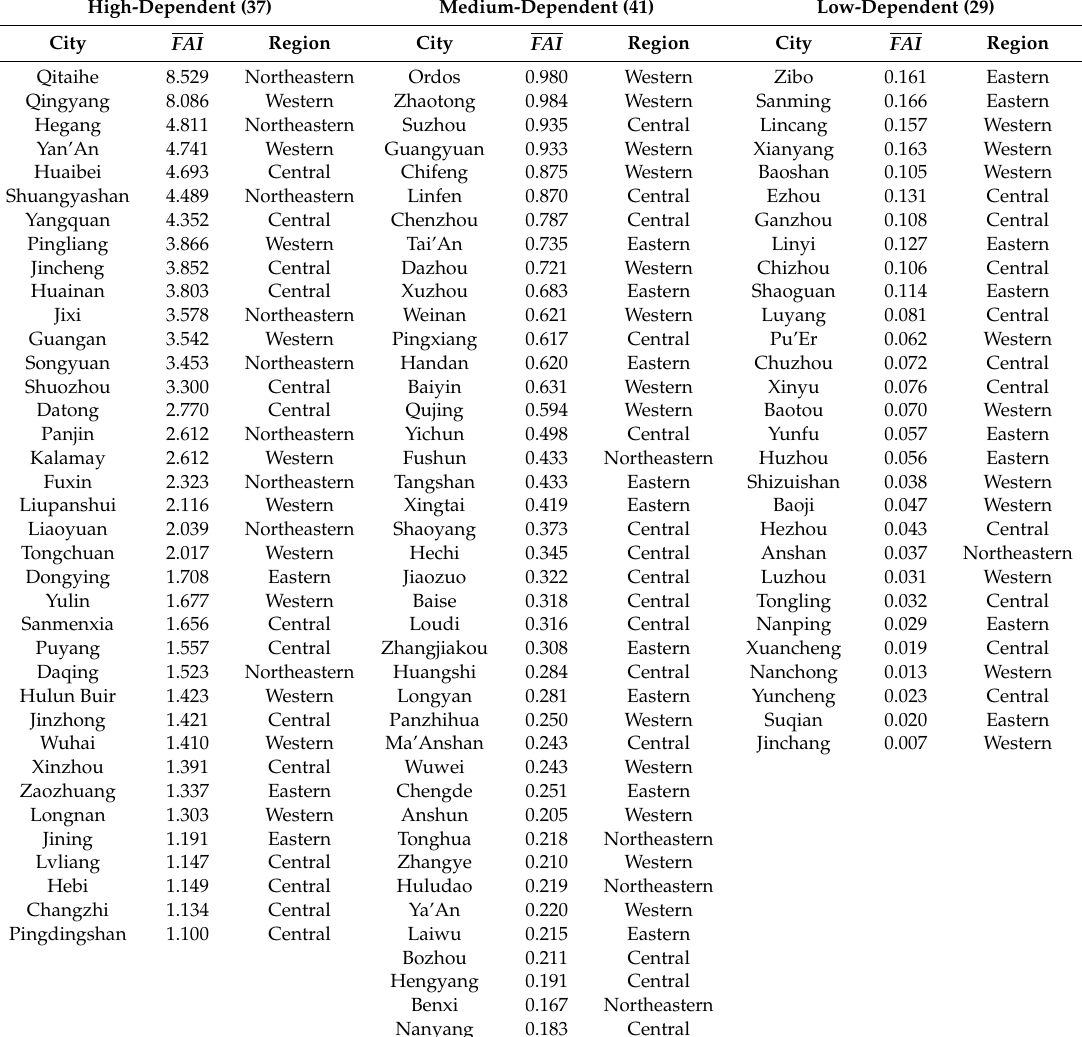
Table 2. The classification of 107 resource-based cities by RD and